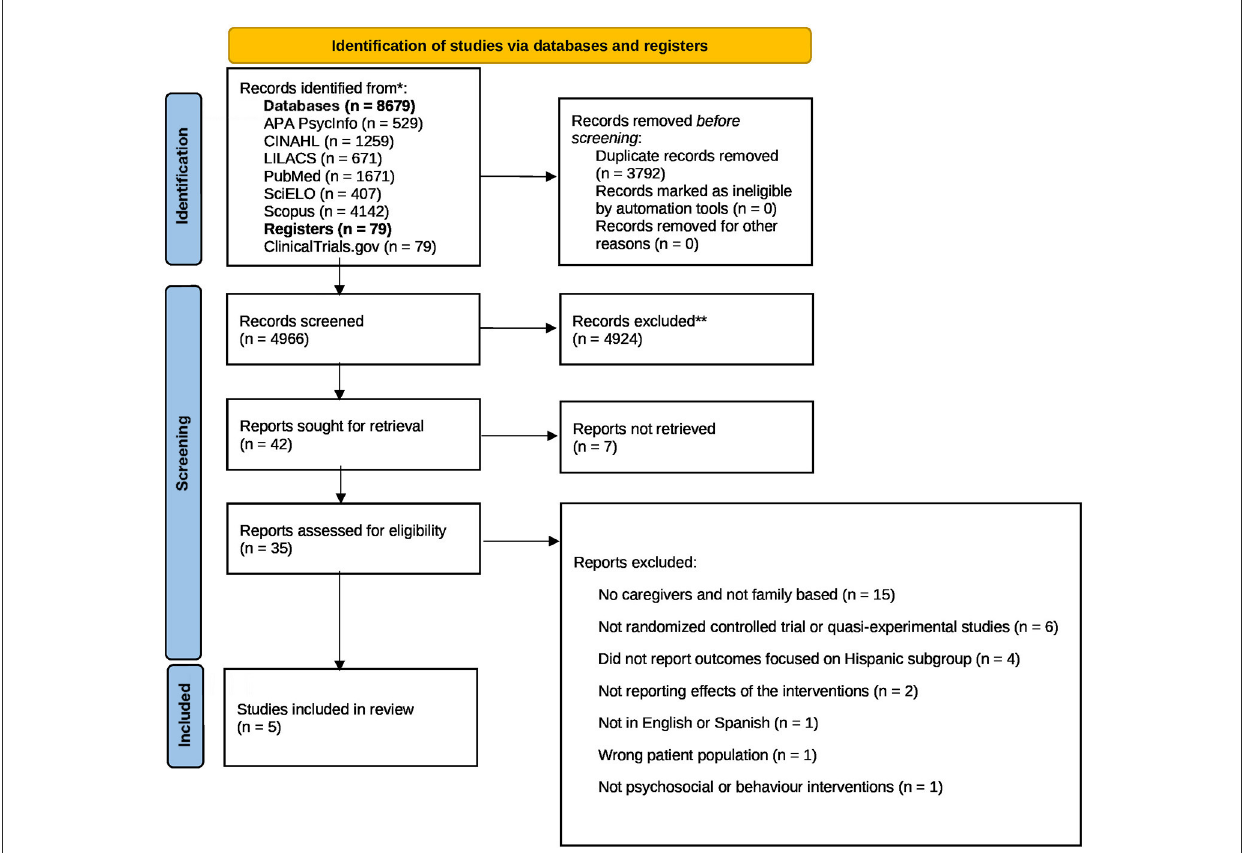
FIGURE1 PRISMA 2020 flow diagram for new systematic reviews which included searches of databases and register only. *Consider, if feasible to do so, reporting the number of records identified from each databases or register searched (rather than the total number across all databases/registers). **If automation tools were used, indicate how many records were excluded by a human and how many were excluded by automation tools. From Page et al. (2021). For more information, visit: